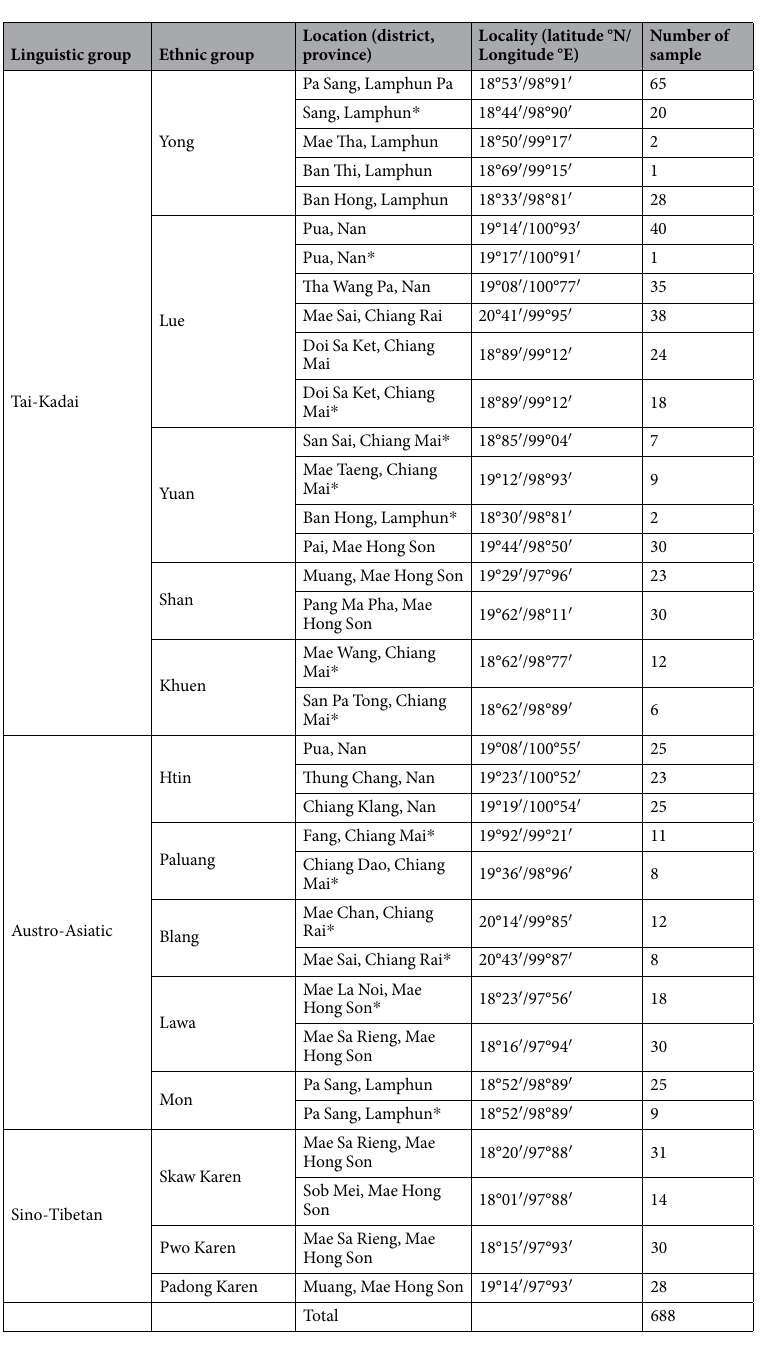
Table 4. Linguistic group, ethnicity, location and number of samples of the 13 ethnic groups. * Previously reported groups screened for 6 types of deletion and point mutation of α -thalassaemia gene for comparison 15